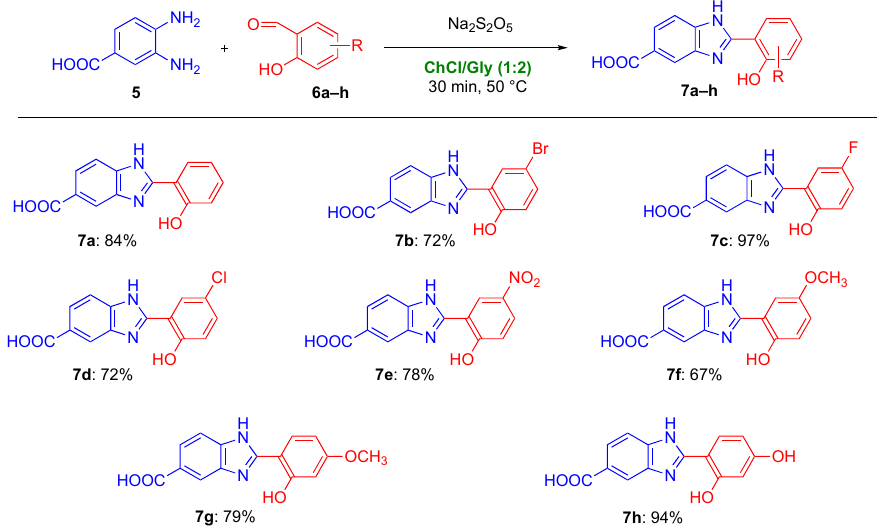
Figure 2. Scope of the cyclodehydration reaction for the synthesis of 2 ‐ hydroxyphenylbenzimidazole derivatives 7 . Yields refer to isolated products.